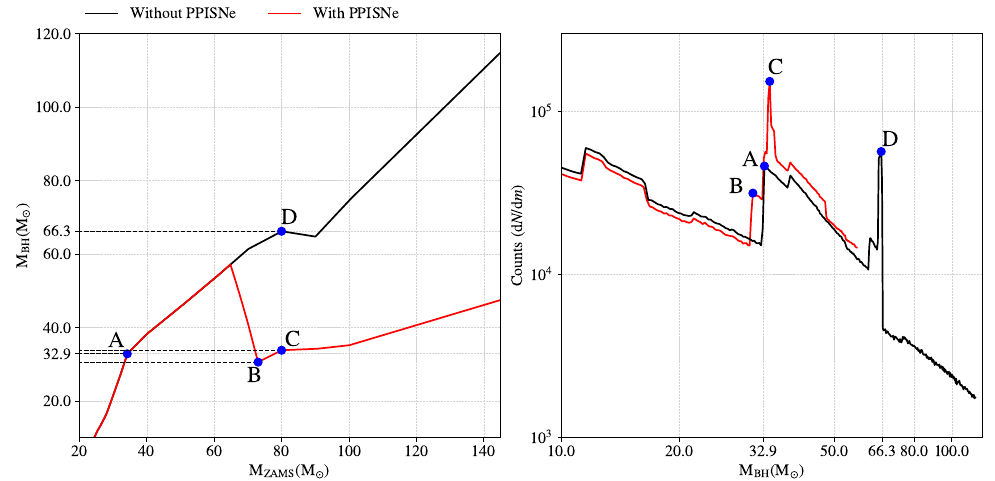
Figure 5. Mass spectrum ( m BH vs M ZAMS , left panel) and mass distribution (d N /d m vs m BH , right panel) of BHs obtained evolving a population of 10 7 single stars. The progenitors follow a power-law initial mass function that scales as d N /dM ZAMS ∝ M ZAMS − 2.3 [203] with masses between 25M (cid:12) and 145M (cid:12) . The black (red) curve shows the results without (with) PPISNe. The points A, B, C, and D represent the kinks of the m BH –M ZAMS curve. The plot has been obtained for Z = 10 − 3 through the SEVN population-synthesis code [22] with PPISNe fitting formulas from [97], look-up tables for single stellar evolution from the PARSEC code [98], and the delayed SN explosion mechanism